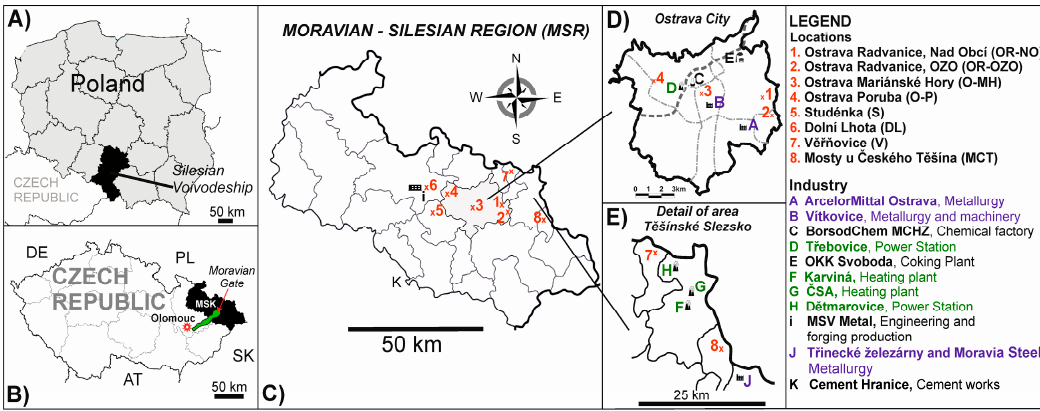
Figure 1. ( A ) Border between Czech Republic and Poland; ( B ) Localization of the Moravian-Silesian Region and Olomouc in the Czech Republic; ( C ) Detail of the Moravian-Silesian Region and localization of the sampling sites; The main pollution sources in Ostrava City ( D ) and in the area of T ě šínské Slezsko ( E ).